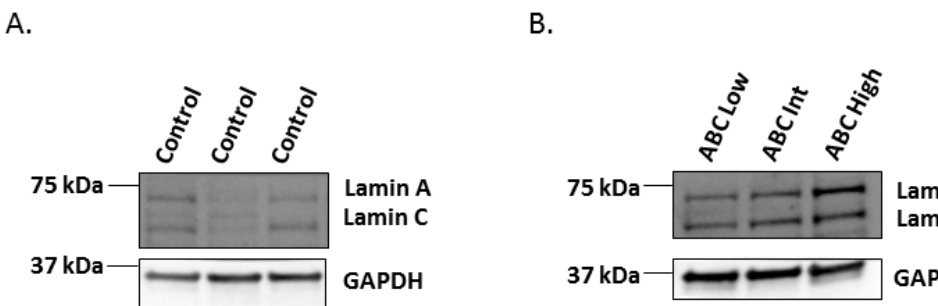
Figure 2. Western blot analysis of Lamin A/C proteins in human hippocampus. ( A ) Both lamin A and lamin C are expressed in control hippocampal samples. ( B ) Increasing tendency of lamin A and C protein expression from low to high ABC stages. GAPDH was used as a control. GAPDH: 37 kDa, Lamin A/C: 70-65 kDa.